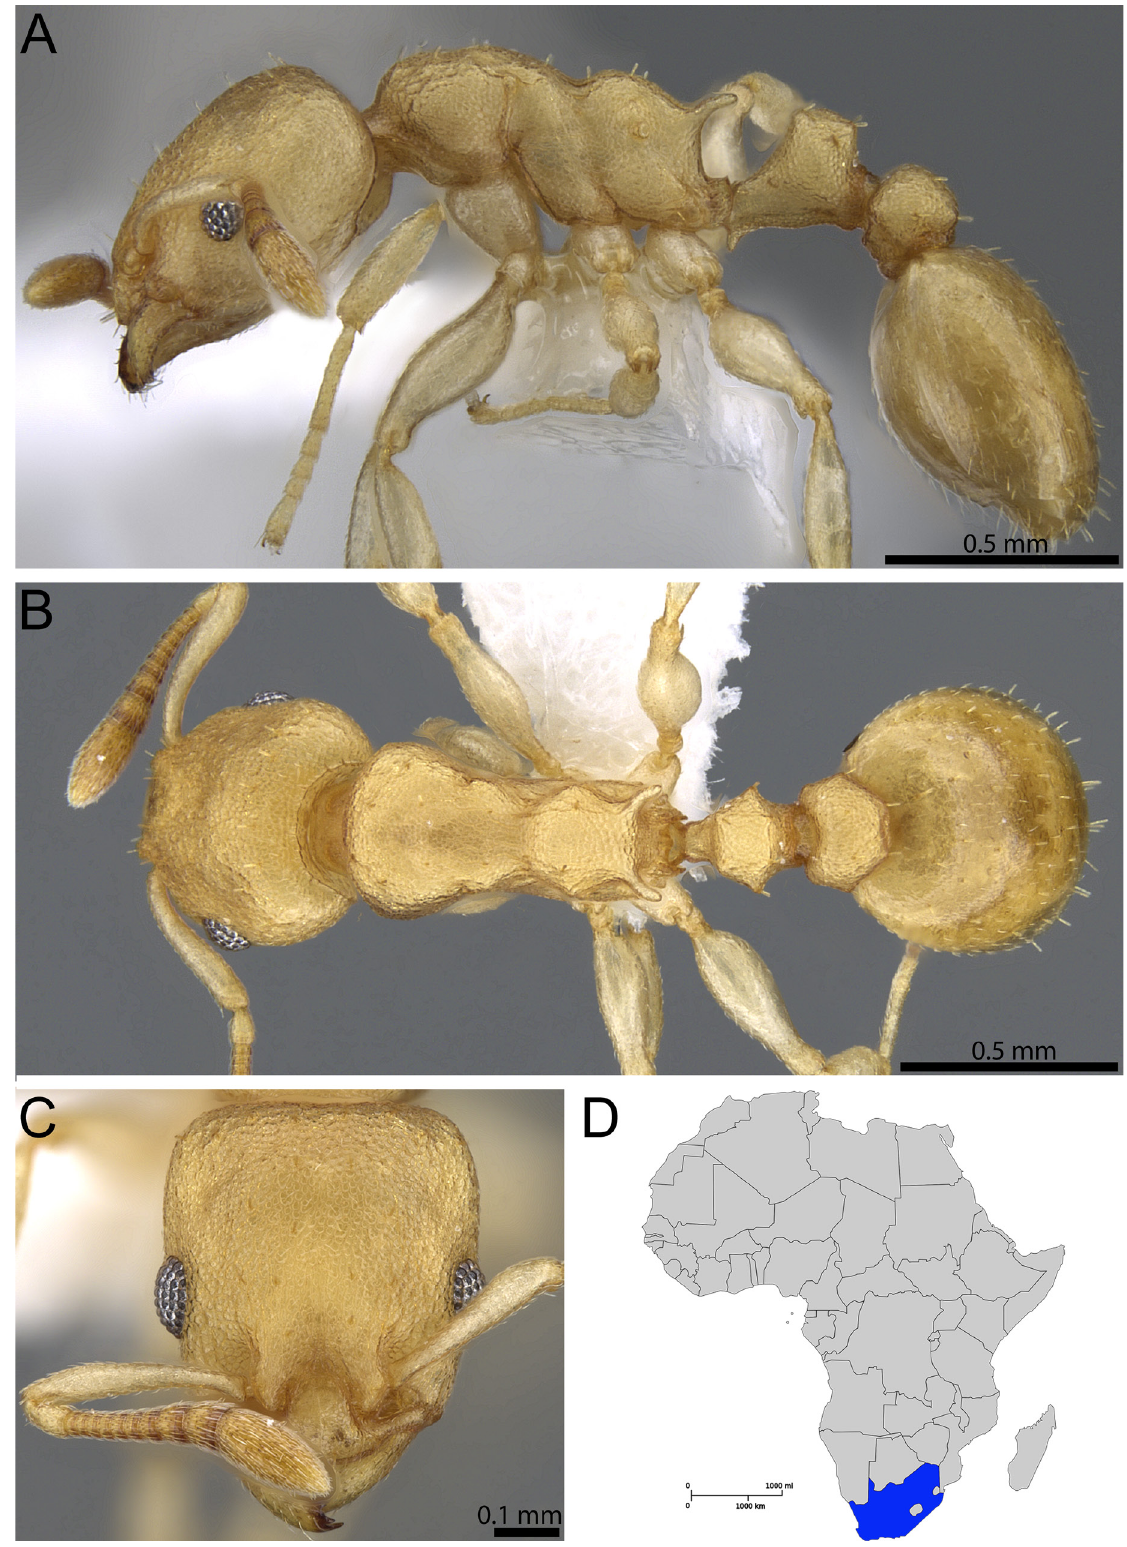
Fig. 20. Nesomyrmex stramineus (Arnold, 1948) (CASENT0922011). A . Body in profile view. B . Body in dorsal view. C . Head in full-face view. D . Map of Africa and Madagascar showing currently known